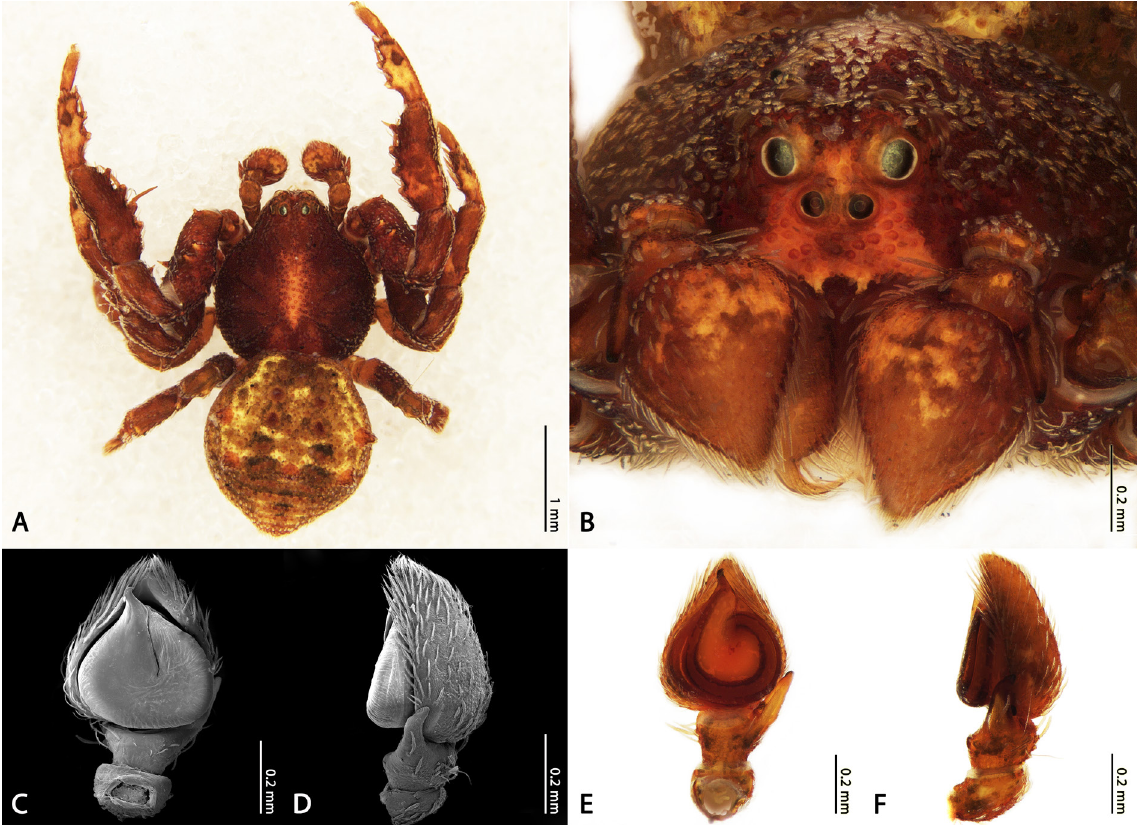
Fig. 8. Male of Kryptochroma parahybana (Mello-Leitão, 1929) gen. et comb. nov. (MPEG 9069). A . Habitus, dorsal view. B . Front. C–F . Left male palp. C, E . Ventral view. D, F . Retrolateral